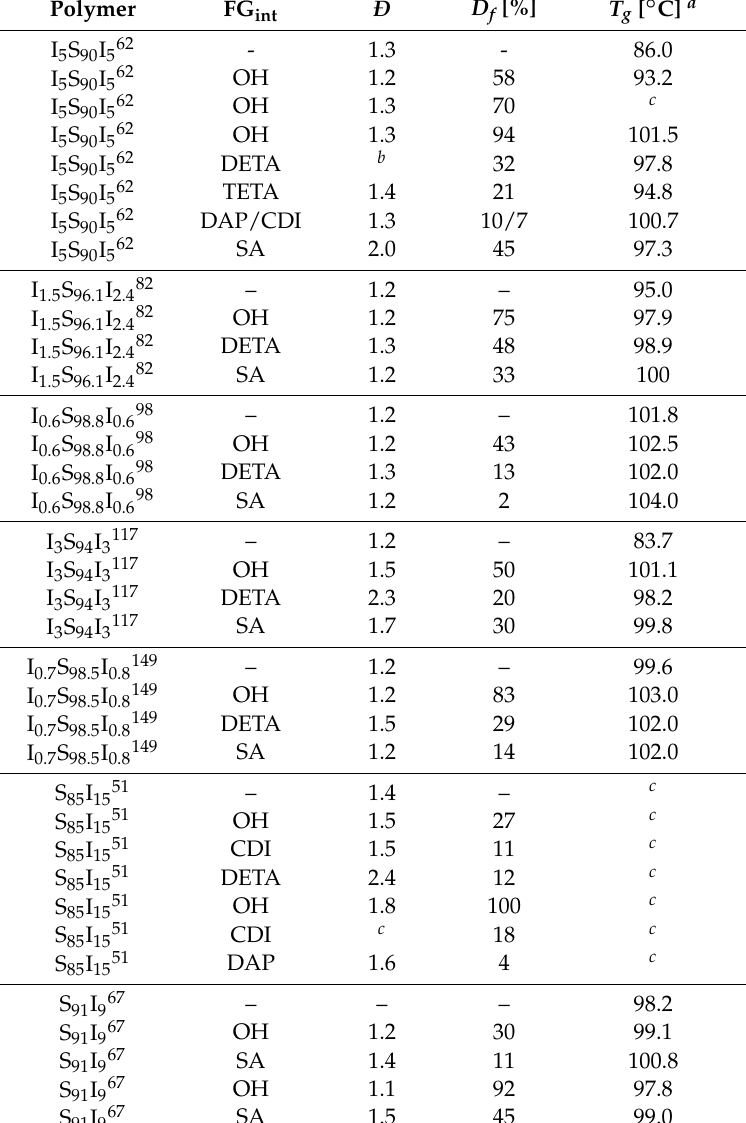
Table 2. Measured and calculated data of different functionalized and unfunctionalized ISI and SI. Listed are the polymeric precursor, the introduced functional group FG int , the degree of functionalization D f , the polydispersity index Đ , and the onset of glass transition temperature T g . Modified samples are listed directly after their OH- or CDI-functionalized